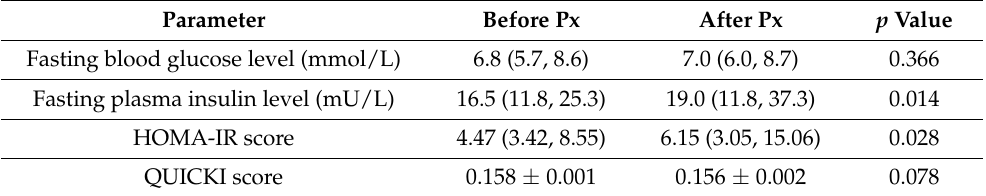
Table 2. Effects of two weeks of Px therapy on blood glucose, plasma insulin levels and insulin sensitivity scores. HOMA-IR (homeostatic model assessment of insulin resistance, derived from product of plasma insulin and glucose concentrations; fasting insulin (microU/L) × fasting glucose (nmol/L)/22.5) and QUICKI (derived from reciprocal of log fasting insulin plus log fasting glucose concentrations; 1/[log(fasting insulin microU/mL) + log(fasting glucose